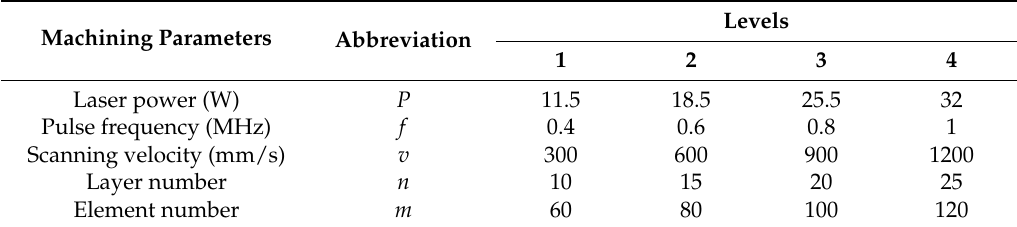
Table 2. The processing parameters used in this study.